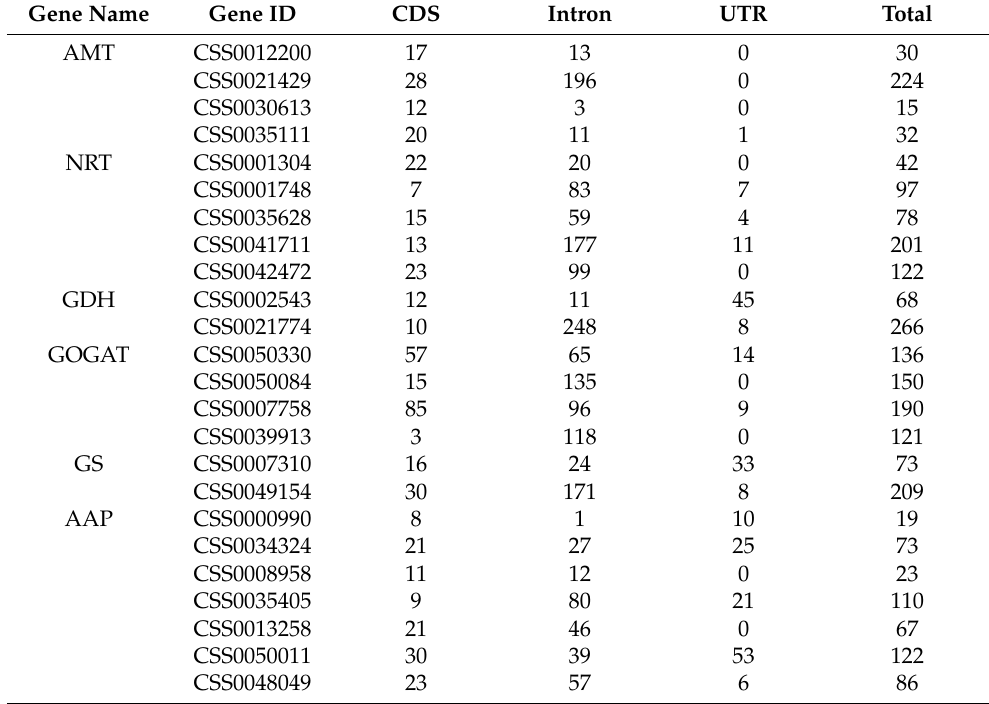
Table 1. Statistics of SNPs within genes related to nitrogen utilization.